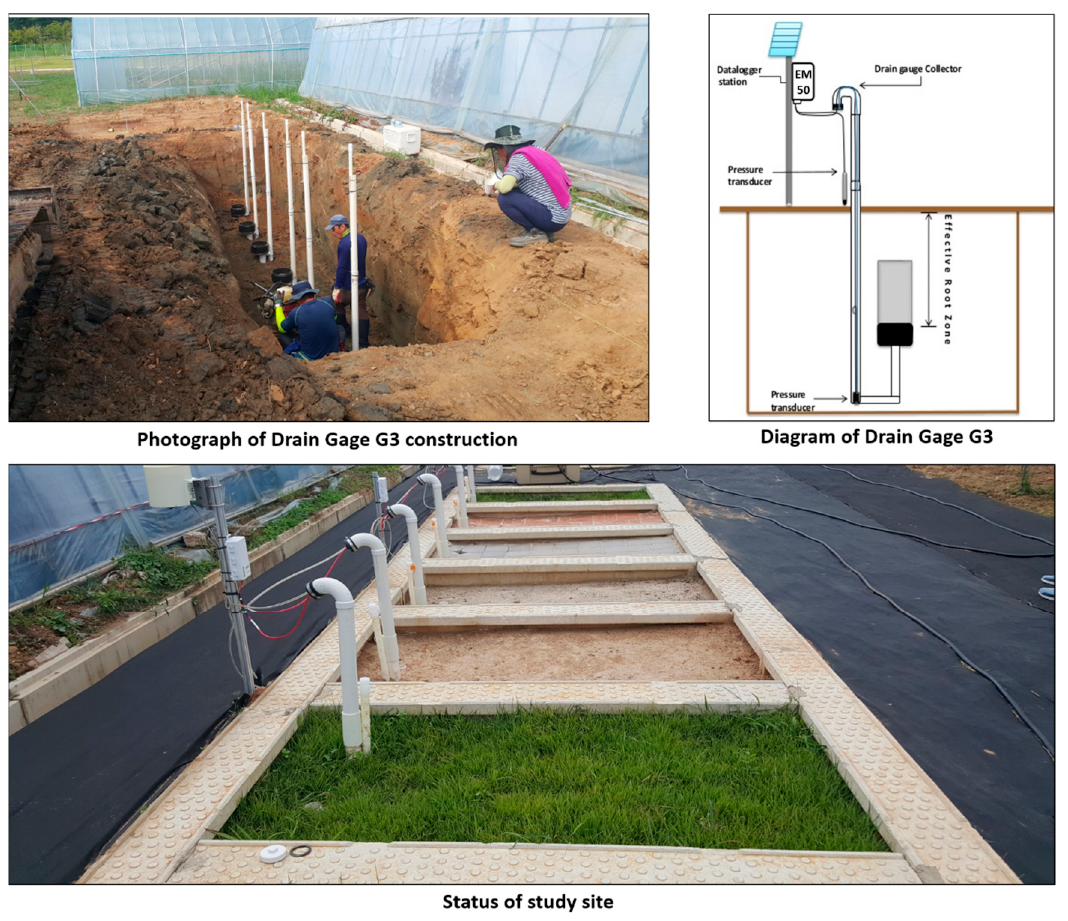
Figure 1. Photograph of Drain Gage G3 ′ s construction, diagram, and status.